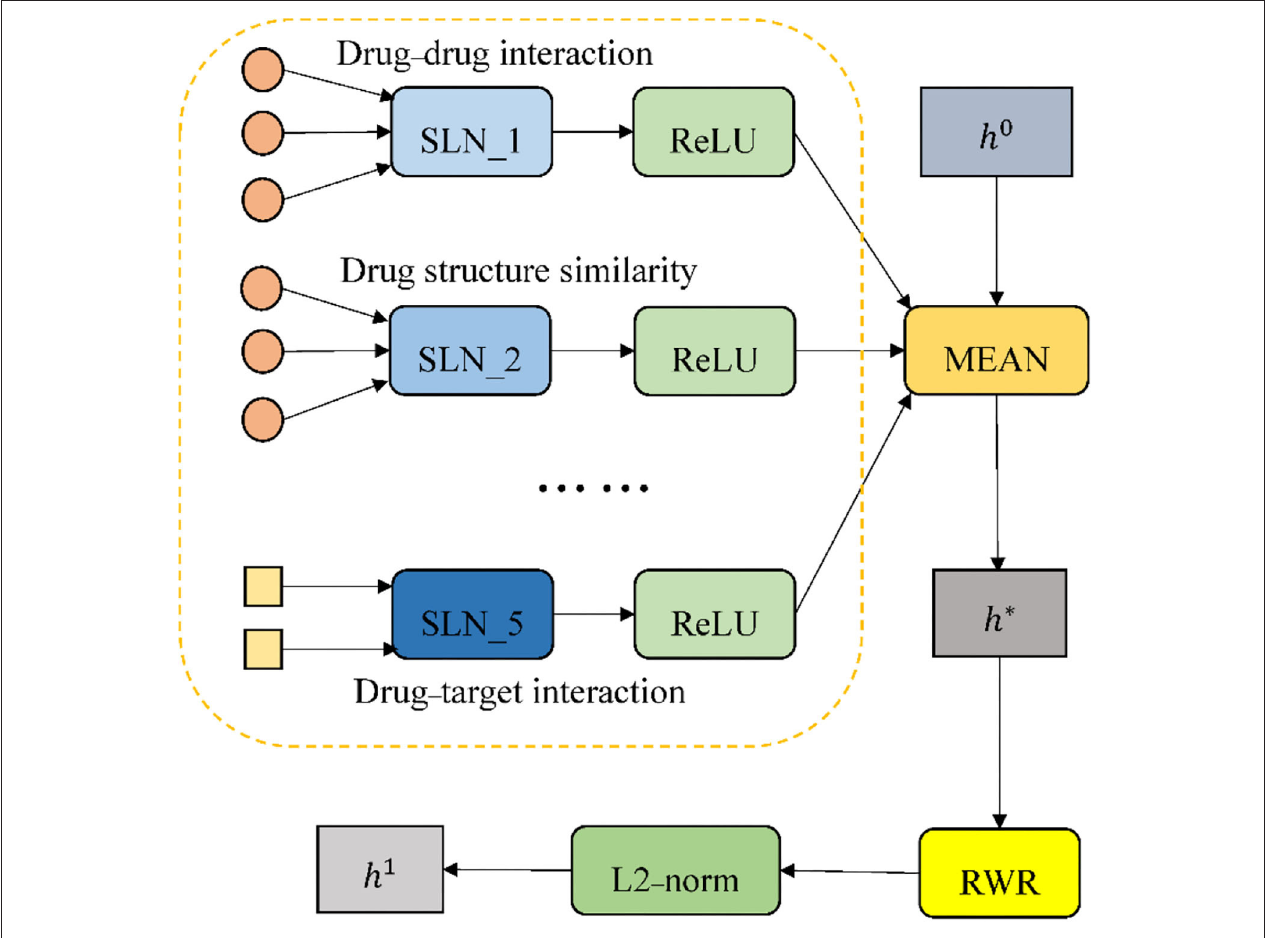
FIGURE 3 | The process of the encoder (taking a drug node as an example).